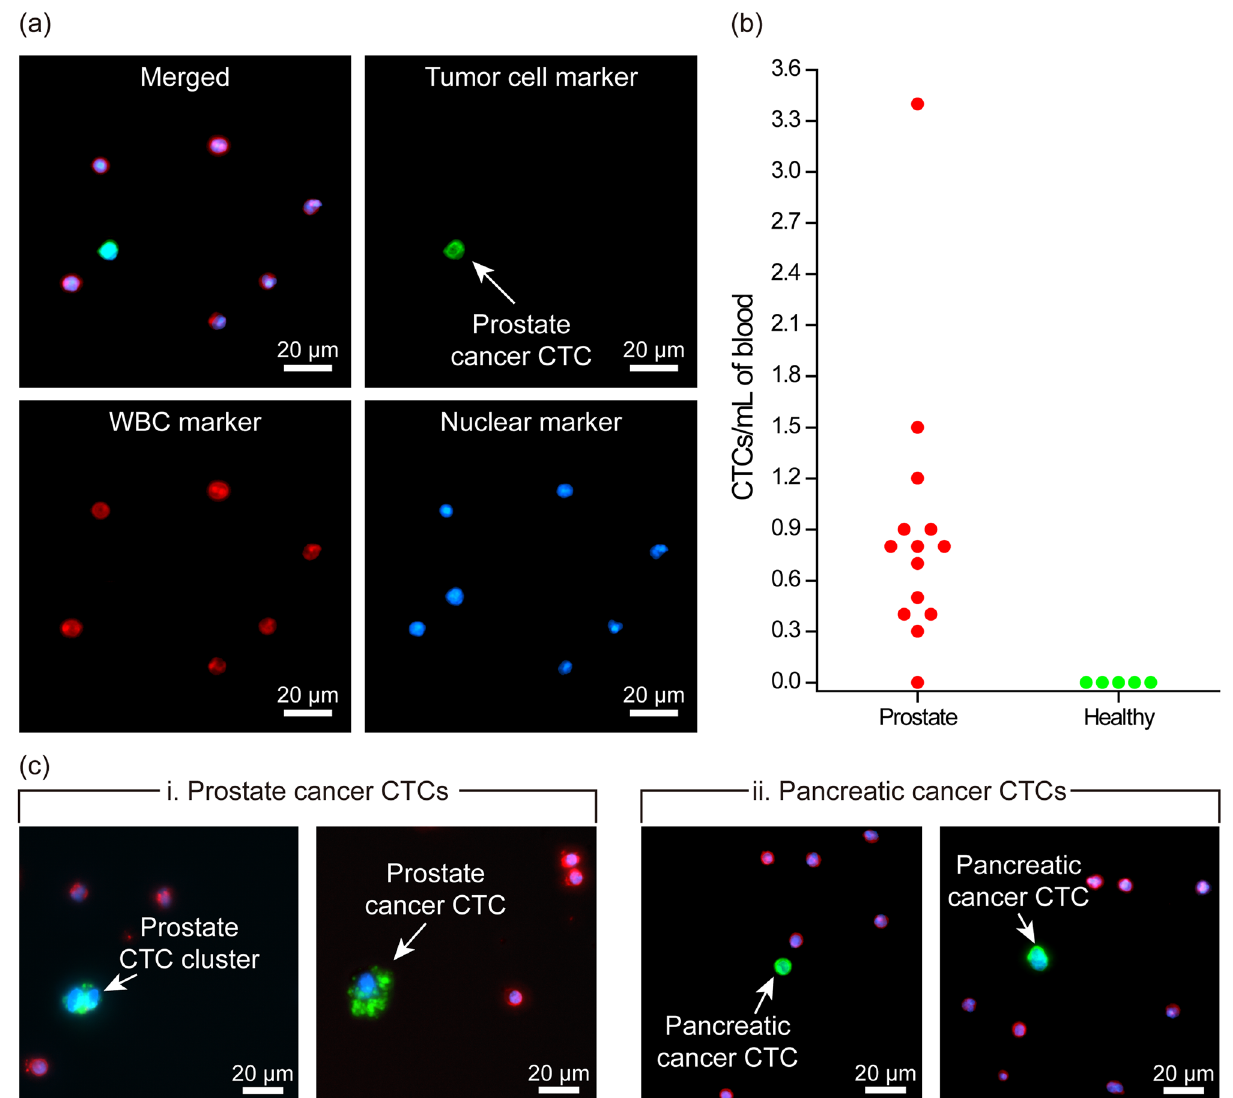
Figure 4. Isolation of circulating tumor cells from clinical samples. ( a ) Fluorescence microscope images of the enriched CTC from a prostate cancer patient’s blood sample. The images show the merged fluorescence image of a CTC isolated from the blood of a prostate cancer patient. Individual fluorescence channels corresponding to immunofluorescence from tumor, WBC and nuclear markers are also shown. ( b ) Measured CTC concentrations in blood samples collected from prostate cancer patients (n = 14) and healthy controls (n = 5). ( c ) Representative immunofluorescence images of patient CTCs isolated from pancreatic and prostate cancer patients’ blood samples. A two-cell CTC cluster was also found in one of the prostate samples, which demonstrates the potential use of the developed device for the enrichment of